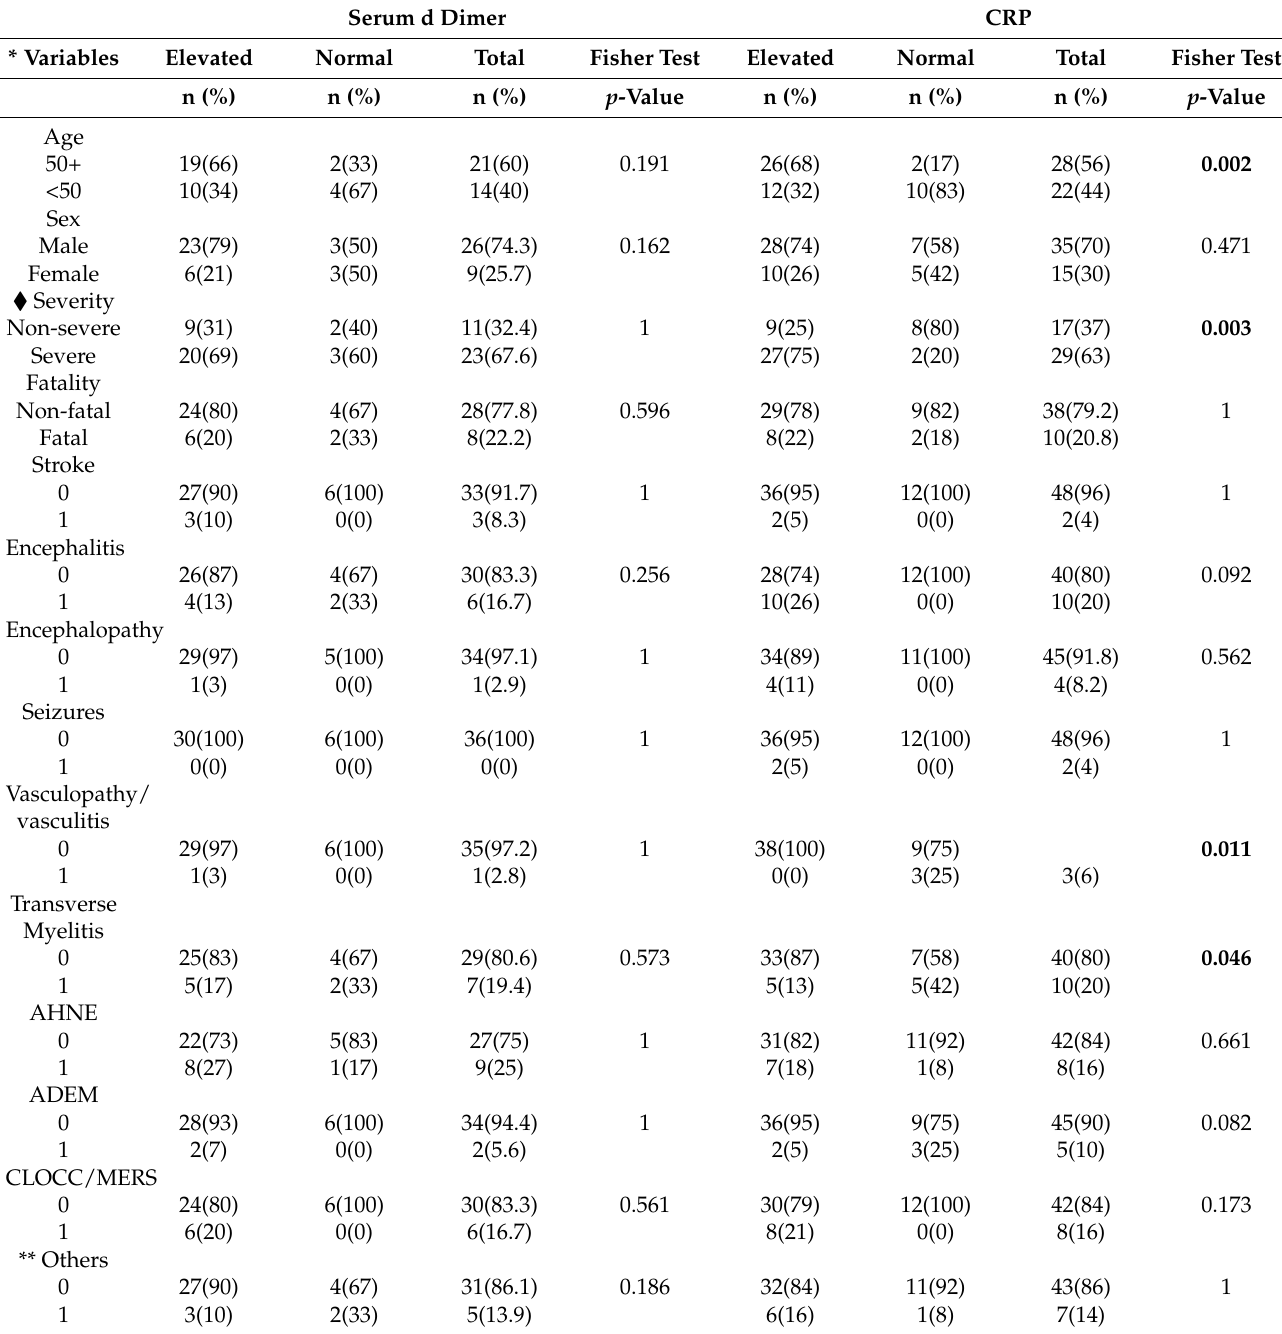
Table 5. Comparison of demographics, severity, fatality and CNS manifestation by serum markers. Serum d Dimer